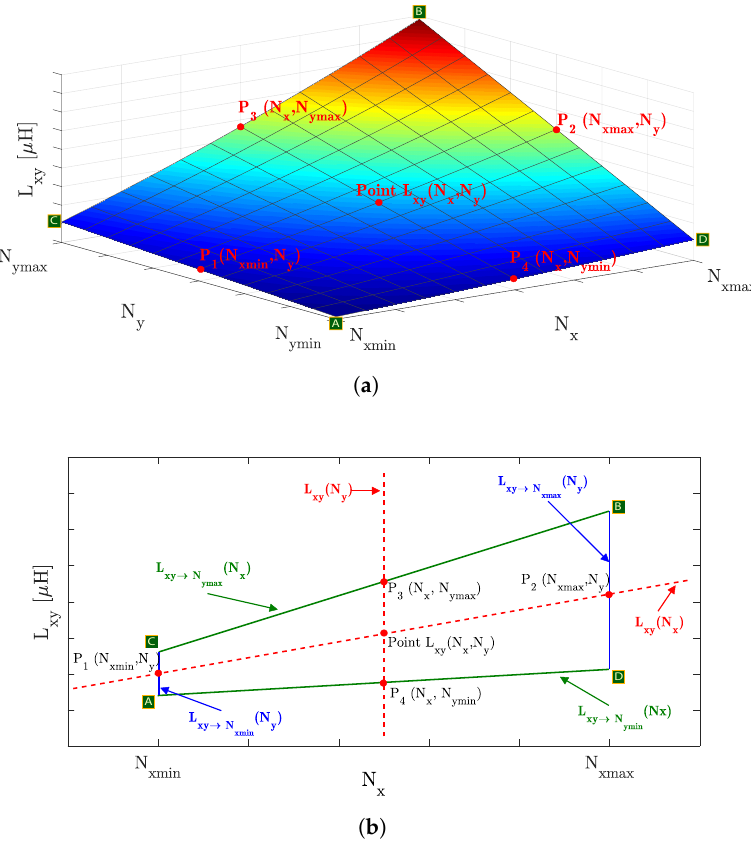
Figure 6. L xy as a function of N 1 and N 2 in 3D view ( a ) and N 1 axis side view ( b ). 2. Replace N x and N y with desired values in surface function L xy = f ( N x , N y ) , deter- mined in step 1, and repeat the process for all simulated Pos . The new values of L xy already take into consideration the effect of the selected set of turns. 3. Profile of L xy = f ( airgap ) : Use the values found in Step 2 for Pos 1 and Pos 2 to determine the constants a 1 and b 1 in (7). Repeat the process for the remaining Pos with the same lateral displacements but different air gap values, i.e., ( Pos 3, Pos 4), ( Pos 5, Pos 6), ... , ( Pos 17, Pos 18). A total of three equations are determined for circular-shaped MCs and nine equations for non-circular MCs. The equations are identified from Exp 1 to Exp 9 in Figure 7a.